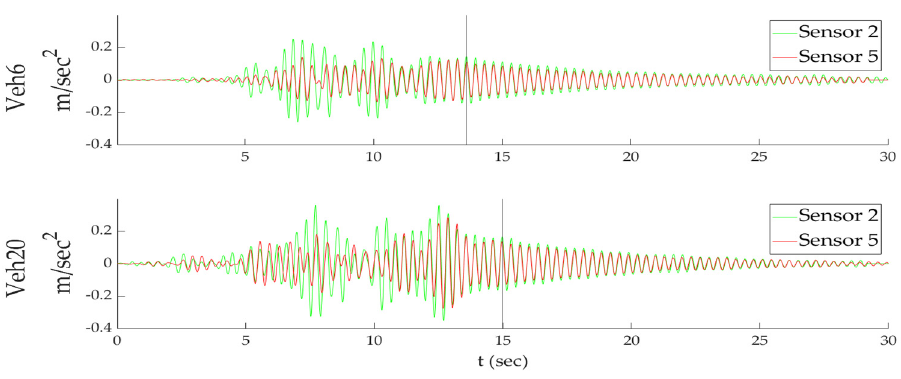
Figure 11. Partial filtered time histories of sensors 2 and 5.